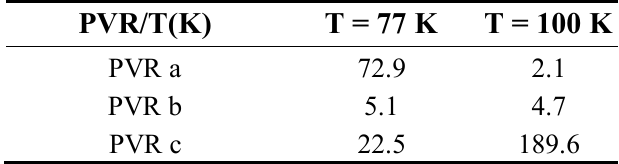
Table 1. Tunneling rate at points a, b and c for temperature of 77 and 100